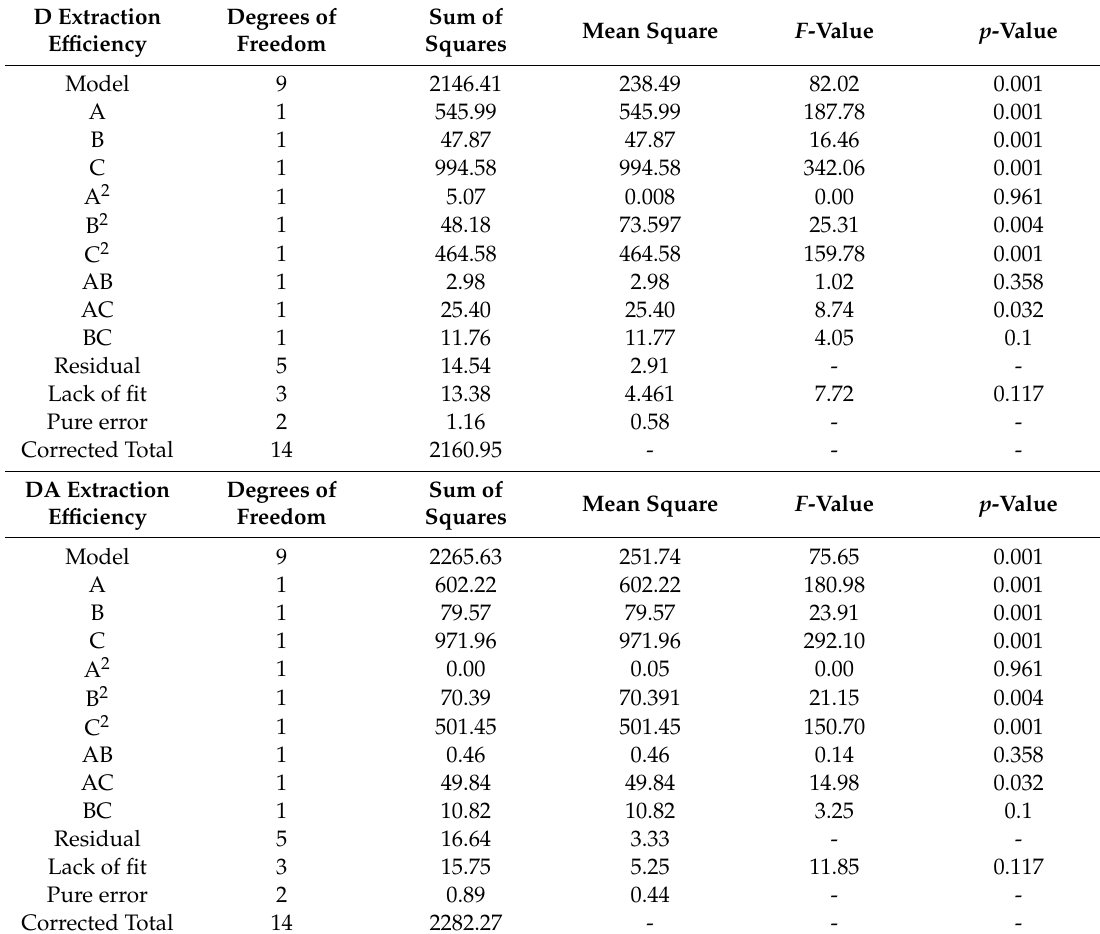
Table 2. Variance analysis for the quadratic response surface regression